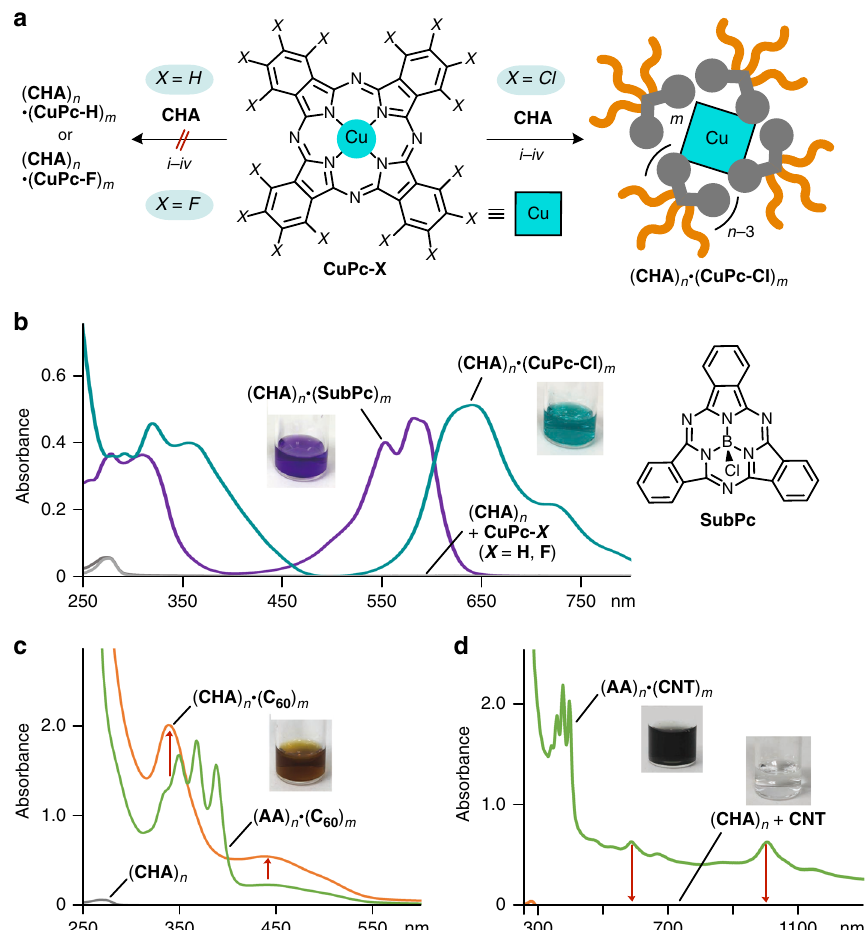
Fig. 4 Selective uptake of substituted metal-complexes and spherical nanocarbons by the cycloalkane-based micelle. a Schematic representation of the uptake of CuPc-X (X = Cl) by ( CHA ) n through ( i ) grinding, ( ii ) water addition, ( iii ) centrifugation, and ( iv ) fi ltration. UV – visible spectra and photographs (H 2 O, room temperature, 1.0 mM based on the amphiphiles) of b ( CHA ) n • ( CuPc-Cl ) m , ( CHA ) n • ( SubPc ) m , and products after treatment of ( CHA ) n with CuPc-X (X = H, F), c ( CHA ) n • ( C 60 ) m and ( AA ) n • ( C 60 ) m , and d ( AA ) n • ( CNT ) m and products after treatment of ( CHA ) n with CNT